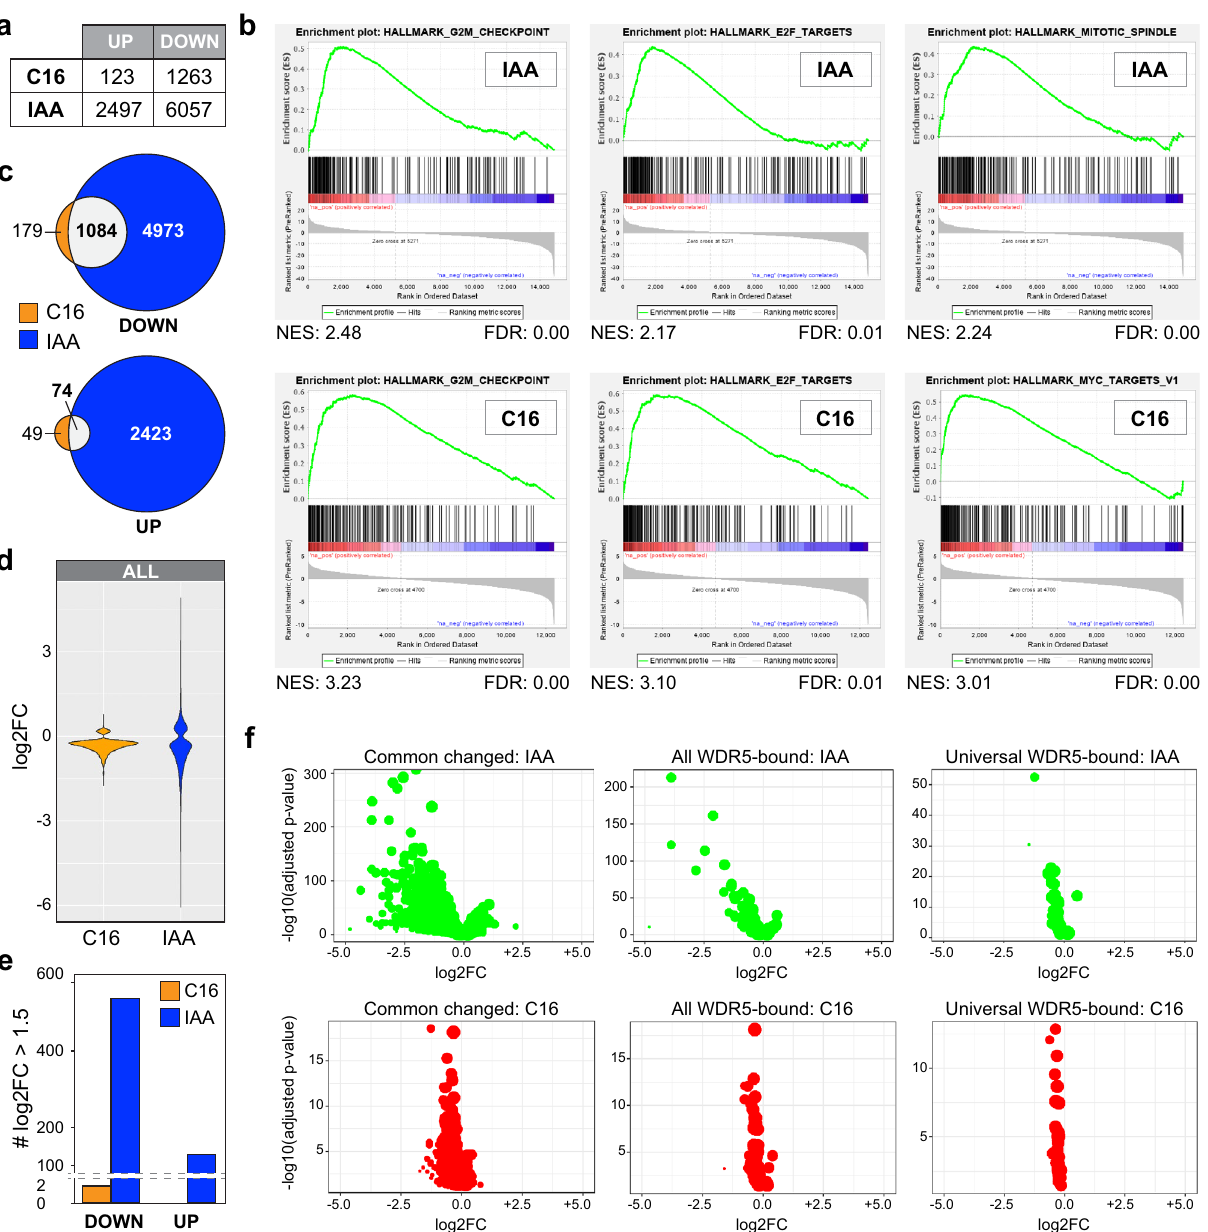
Figure 2. Transcriptomic impact of WDR5 loss versus WIN site inhibition. ( a ) Summary of RNA-Seq, showing the number of differentially expressed genes (FDR < 0.05) altered by 18 h treatment of AIDW cells with 500 nM C16 or 100 μM IAA. N = 4. ( b ) Gene set enrichment analysis (GSEA) of RNA-Seq data from IAA-(top) and C16-(bottom) treated AIDW cells. Top three categories are shown; full results are in Supplementary Tables S1 and S2. NES normalized enrichment score, FDR false discovery rate. ( c ) Venn diagram, showing the overlap of transcripts decreased or increased in response to IAA or C16 treatment of AIDW cells. ( d ) Violin plot, displaying the magnitude of significant transcript changes associated with C16 or IAA treatment, plotted as log 2 -fold change (log2FC). ( e ) Graph comparing the number of transcripts with log2FC > 1.5 in AIDW cells in response to IAA or C16 treatment. ( f ) Volcano plots, comparing transcript changes in IAA- (top) or C16- (bottom) treated AIDW cells, confined to either: (i) transcripts that change in both the IAA and C16 samples (left), (ii) transcripts from genes bound by WDR5 in Ramos cells 4 (middle), and (iii) transcripts from genes “universally” bound by WDR5 in human cell lines 2 (right). Bubble size indicates mean of normalized counts of all samples, normalizing for sequencing